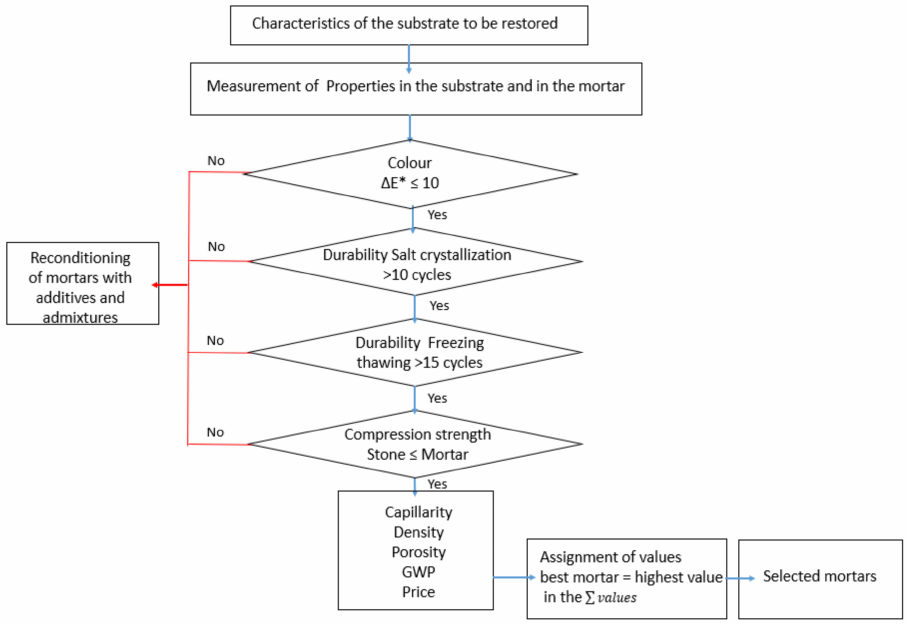
Figure 1. Diagram of the proposed methodology for the selection of sustainable restoration